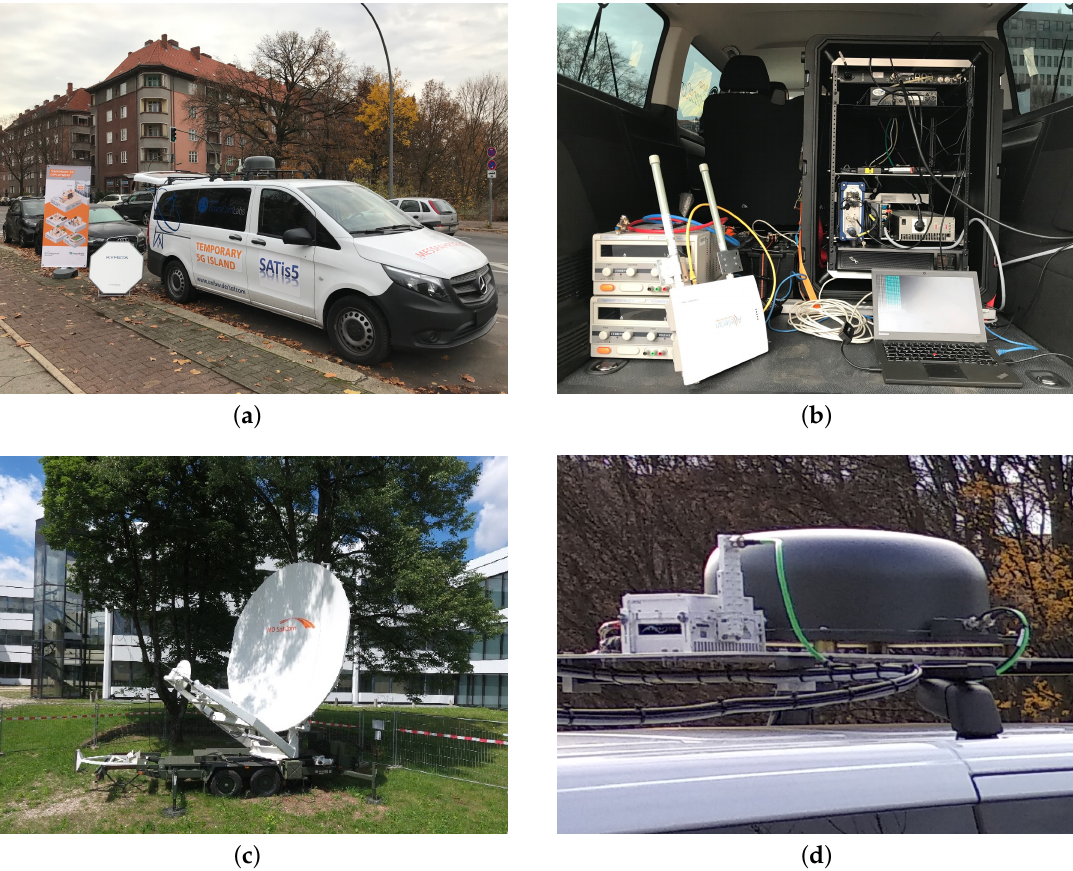
Figure 15. 5G connectivity on the move demo: hardware setup of the SATis5 testbed. ( a ) SATCOM Van; ( b ) Mobile base station deployment showcase; ( c ) 4.6m Earth station antenna; ( d ) SOTM